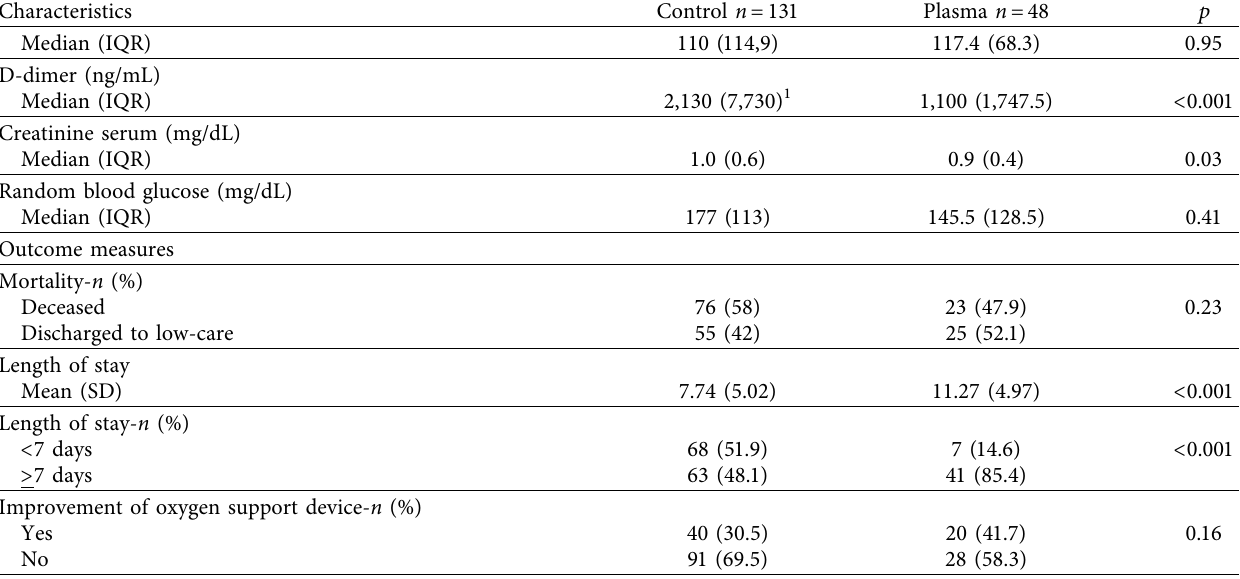
Table 4. The area under ROC curve of this model was